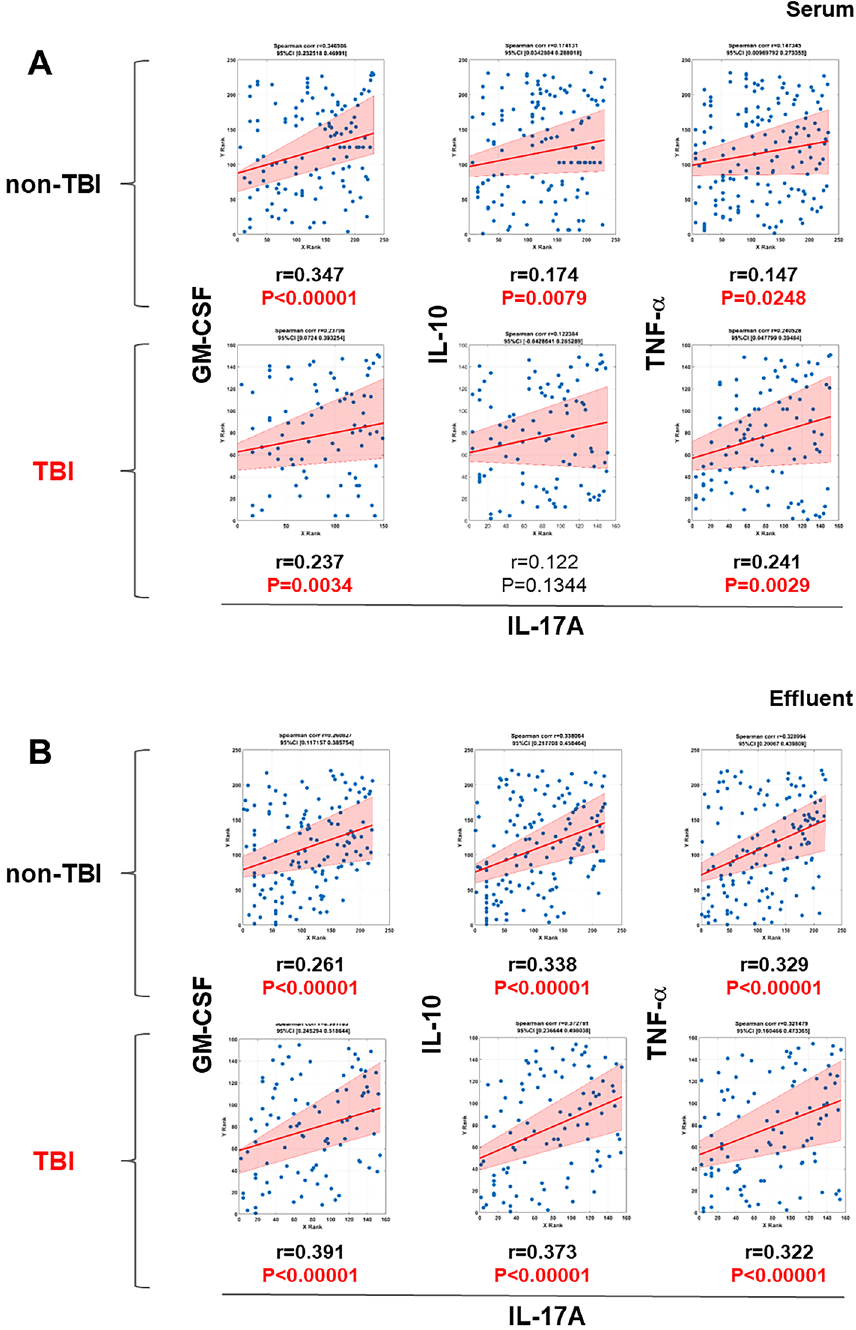
Figure 4. Correlation between levels of IL-17A/GM-CSF, IL-17A/IL-10 and IL-17A/TNFα in serum and wound effluent samples from TBI and non-TBI patients. Inflammatory mediators in serum and wound effluent samples of trauma patients taken during five consecutive debridements were measured by Luminex™ as described in “Materials and methods”. The plots show the Spearman’s correlations between levels of IL-17A/ GM-CSF, IL-17A/IL-10 and IL-17A/TNFα in serum ( A ) or wound effluent samples ( B ) from TBI vs. non-TBI patients (the shaded area represents the 95% bootstrapped confidence